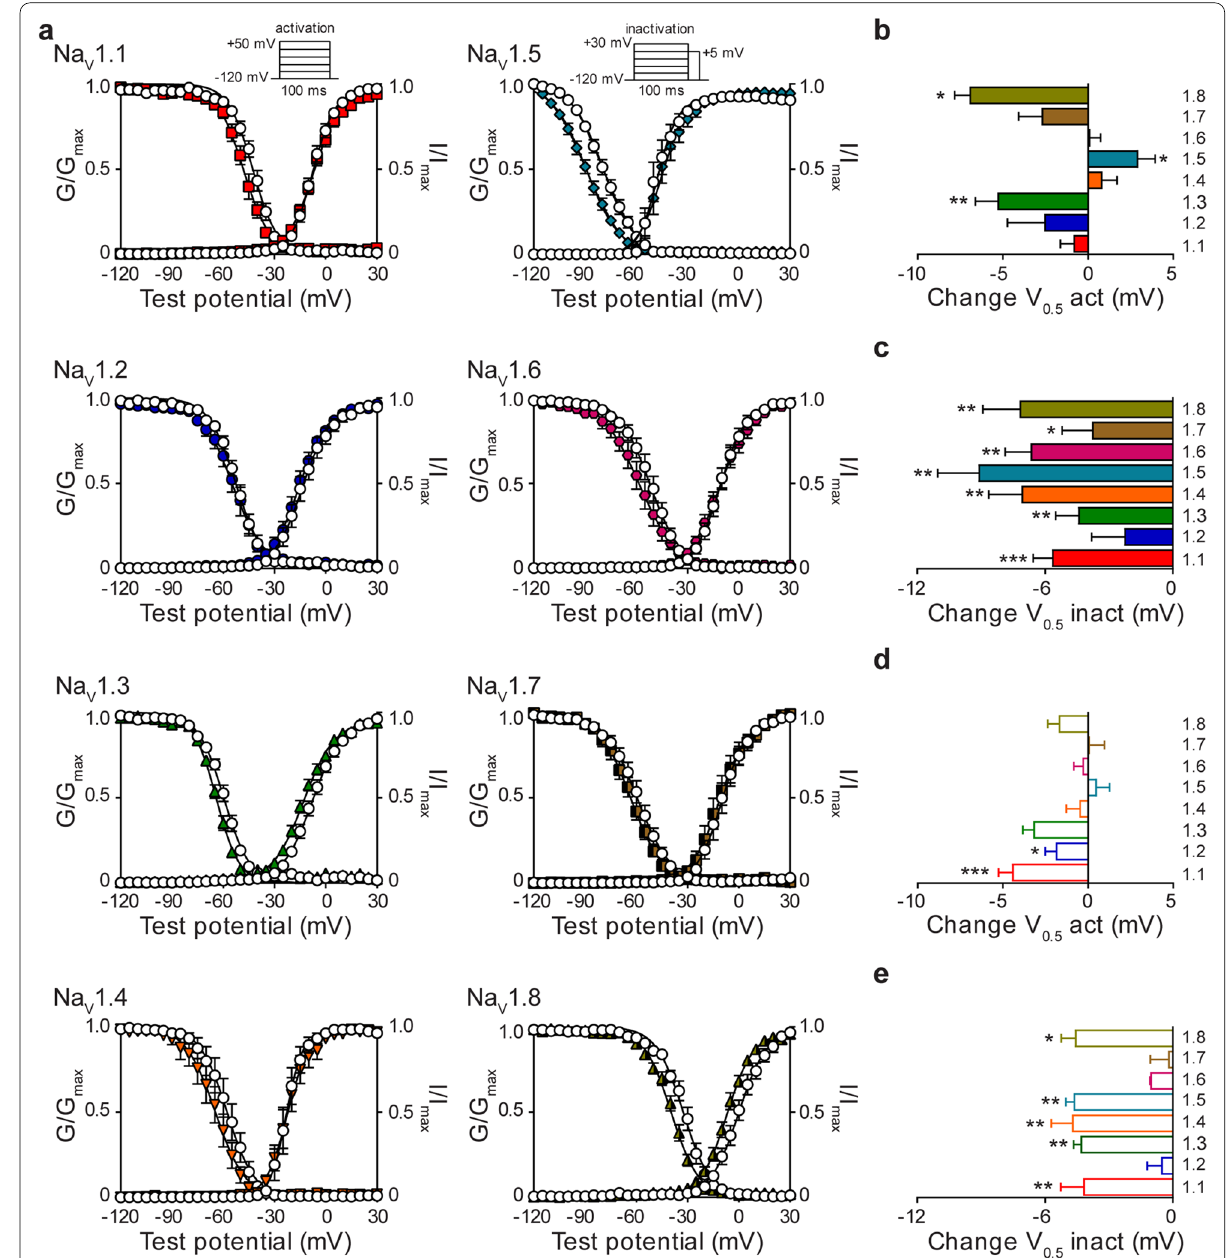
Fig. 2 The effects of NP on activation and steady-state fast inactivation (SSFI). a Voltage-dependence of normalized peak conductance (G/G max ) and SSFI (I/I max ), evoked by the indicated voltage protocols (insets), in the presence of vehicle ( ) or NP (3 μg NP/mL) for Na V 1.1 ( ; n 10; mean diff = slope act 1.5 0.3, p 0.002), Na V 1.2 ( ; n 8), Na V 1.3 ( ; n 10), Na V 1.4 ( ; n 6; mean diff slope act 1.6 0.6, p 0.04; mean diff slope inact 0.8 0.3, ± = = = = ± = ± p 0.03), Na V 1.5 ( ; n 10; mean diff slope act 2.1 0.5, p 0.003; mean diff slope inact 0.8 0.3, p 0.003), Na V 1.6 ( ; n 11; mean diff slope act = = ± = ± = = 1.3 0.4, p 0.01), Na V 1.7 ( ; n 7) and Na V 1.8 ( ; n 7). Boltzmann curves were fitted to pooled averages of peak conductance. b Average change ± = = = in the voltage of half (V 0.5 ) activation and c SSFI initiated by NP (3 μg NP/mL) for Na V 1.1 ( ; n 10), Na V 1.2 ( ; n 8), Na V 1.3 ( ; n 10), Na V 1.4 ( = = = ; n 6), Na V 1.5 ( ; n 10), Na V 1.6 ( ; n 11), Na V 1.7 ( ; n 7) and Na V 1.8 ( ; n 7). d Average change in the voltage of half V 0.5 activation and e SSFI = = = = = caused by hemp seed oil (3 μg hemp seed oil/mL) for Na V 1.1 ( ; n 11), Na V 1.2 ( ; n 5), Na V 1.3 ( ; n 5), Na V 1.4 ( ; n 9), Na V 1.5 ( ; n 6), Na V 1.6 = = = = = ( ; n 6), Na V 1.7 ( ; n 10) and Na V 1.8 ( ; n 5). Data points are mean SEM. Statistical significance is marked as * p< 0.05; ** p< 0.01; *** p< = = = ±